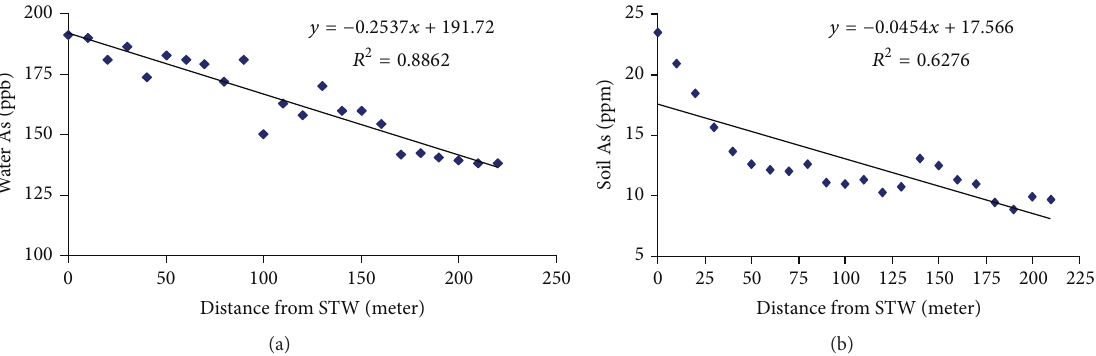
Figure 5: (a) Relationship between water As and distance from the source (STW). (b) Relationship between soil As and distance from the source